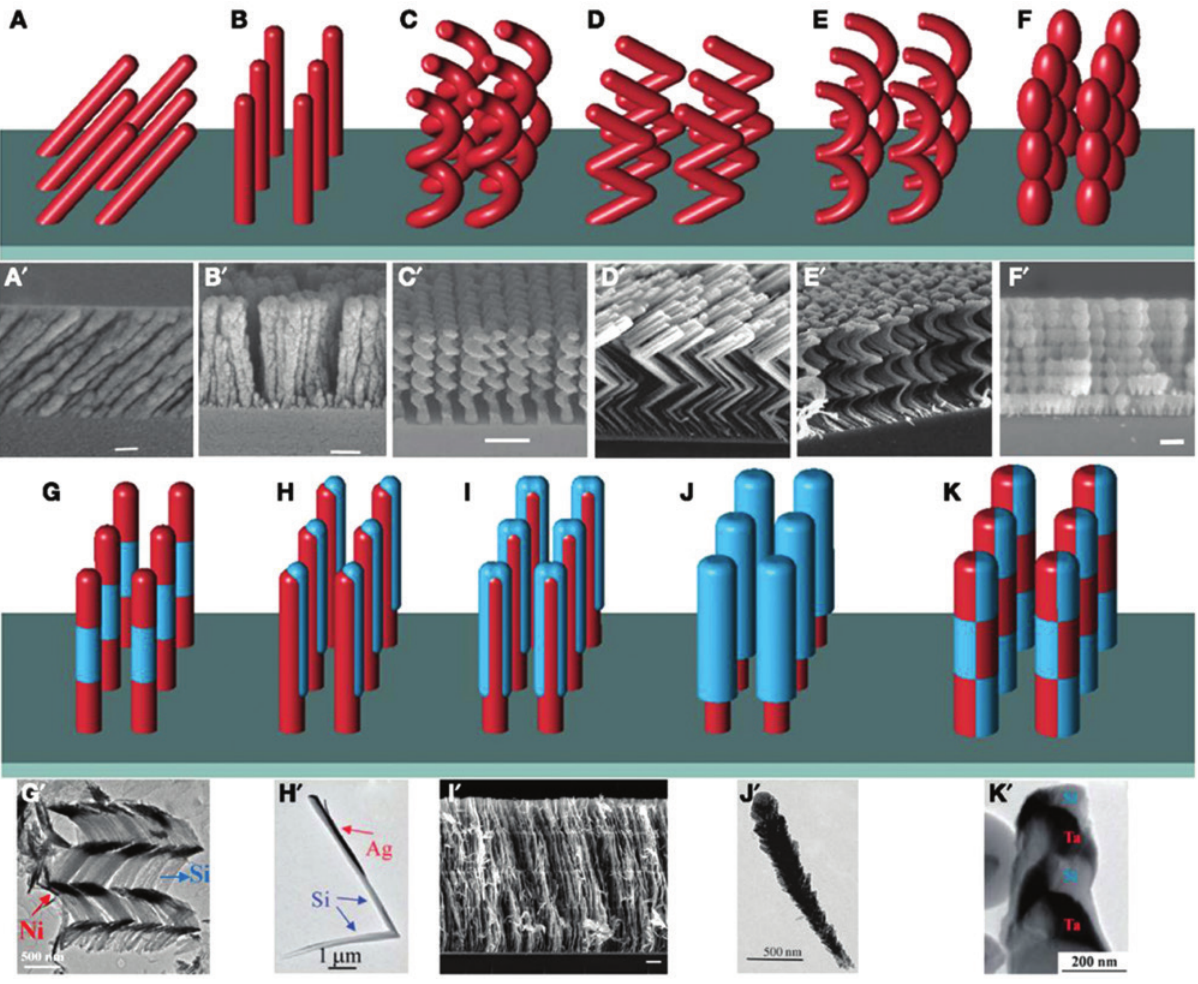
Figure 3: SEM images of typical nanorod arrays fabricated by